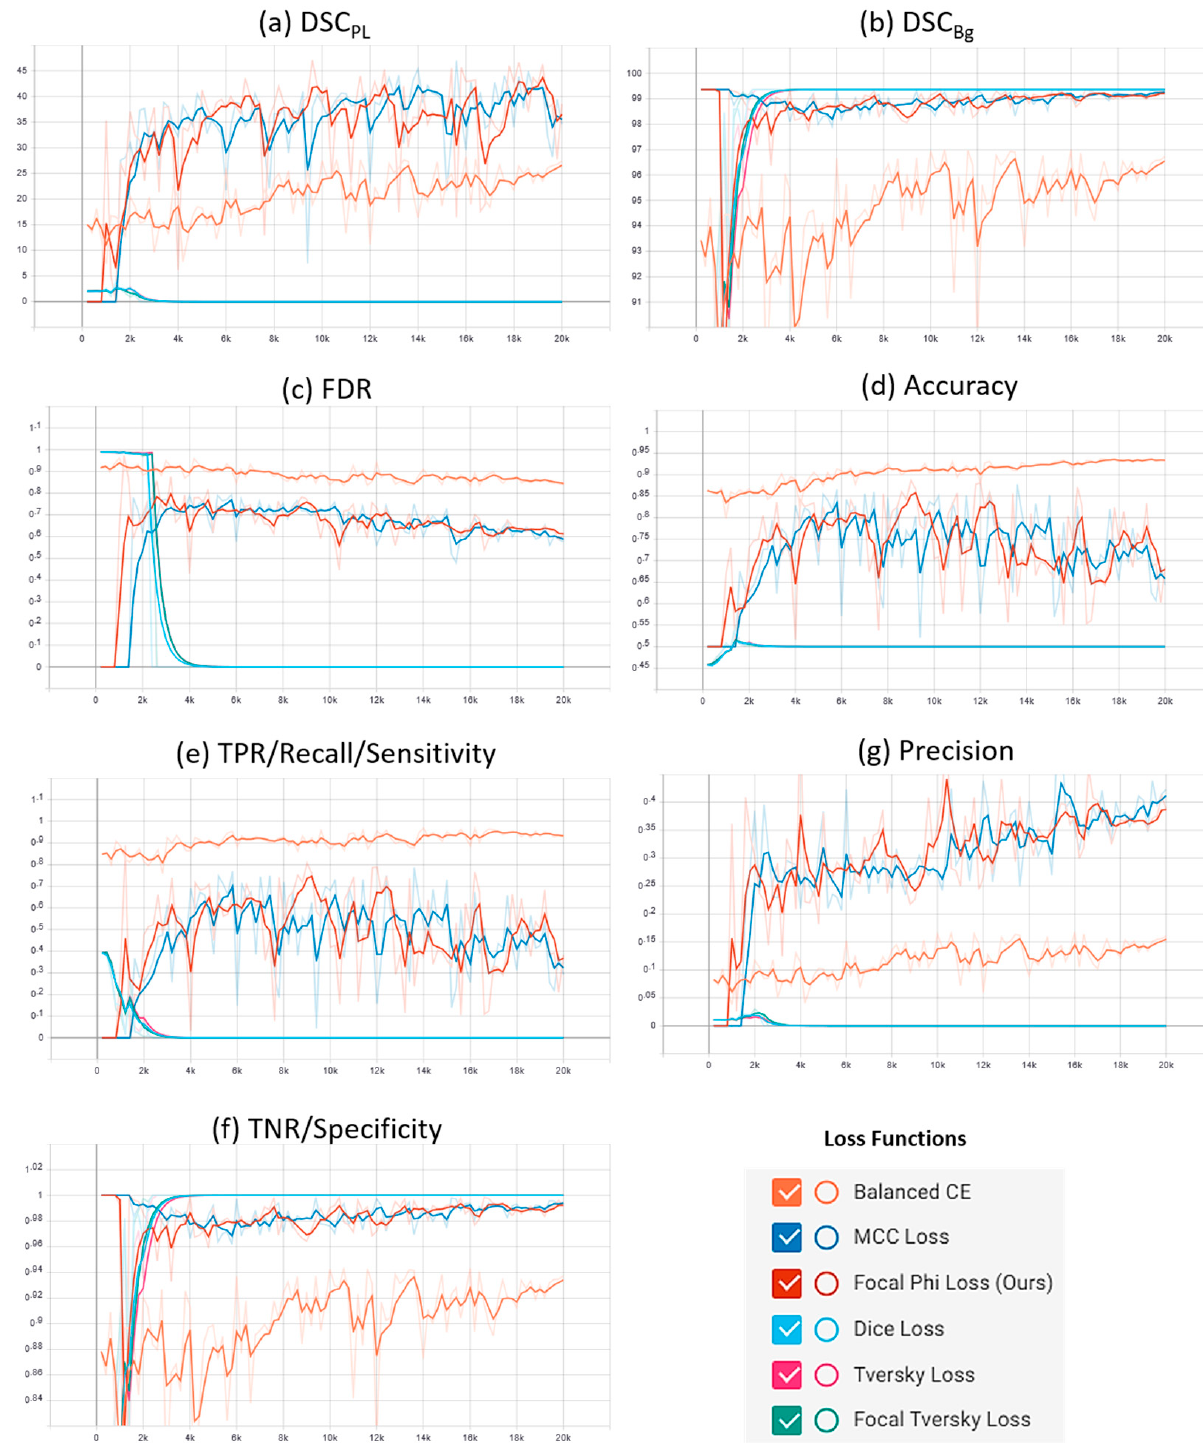
Figure 7. Comparative analysis of the proposed focal Phi loss (FPL) function with various loss functions for class imbalance on PLDU.